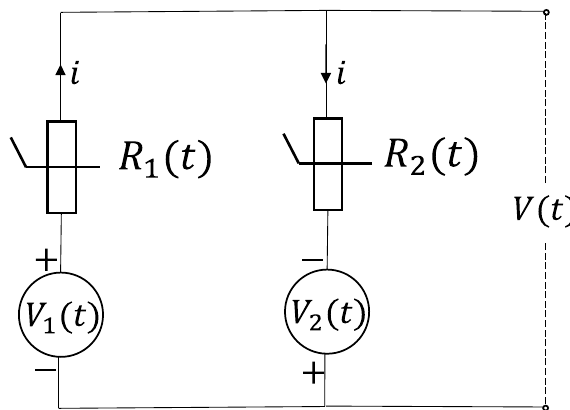
Figure 6. Schematic diagram for a linear HTS flux pump.